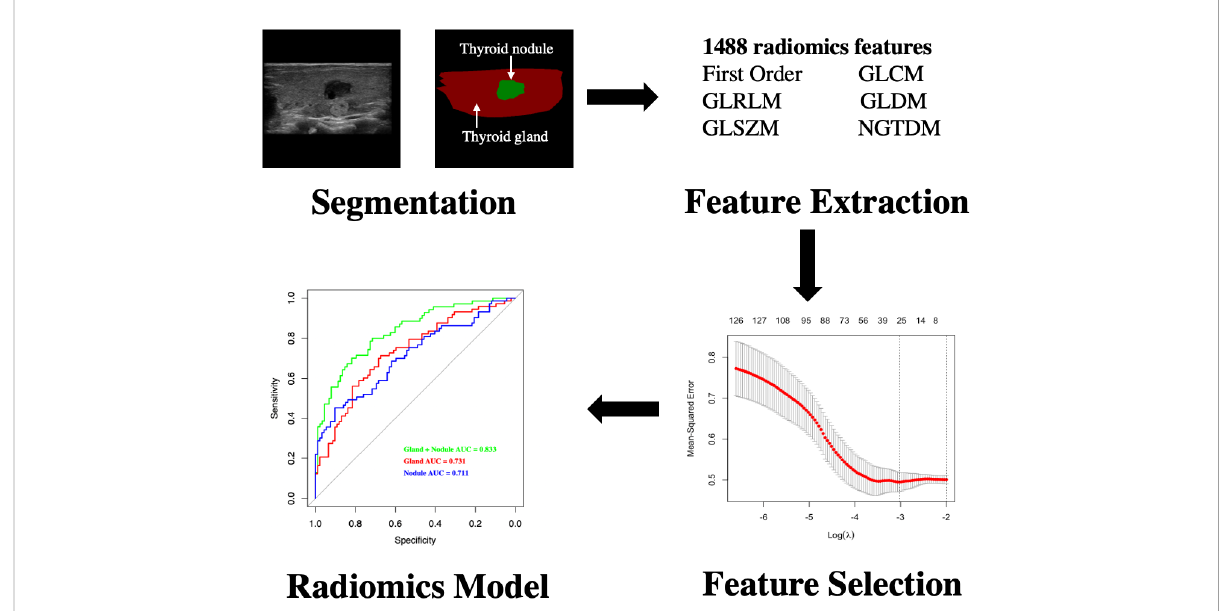
FIGURE 2 Flowchart of development of radiomics model for differentiating CLNM of PTC patients with HT. CLNM, central lymph node metastasis; PTC, papillary thyroid carcinoma; HT, Hashimoto ’ s